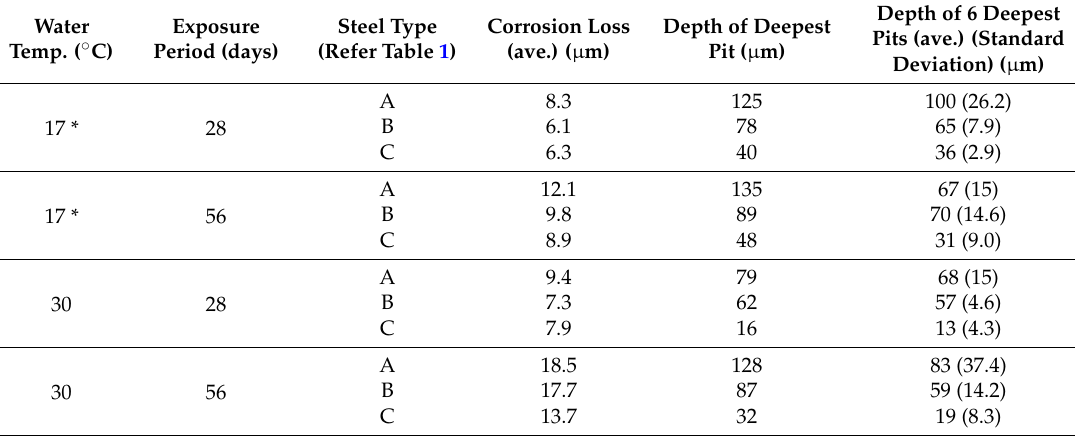
Table 2. Corrosion loss and maximum pit depth (maximum, mean and standard deviation) of steels A, B, and C in seawater at 28 and 56 days